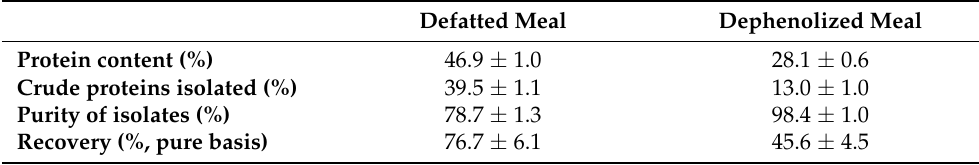
Table 1. Protein content and protein recovery from defatted hazelnut meal (dry basis). Table 2. Amino acid profile of hazelnut meal protein isolate (mg/g protein).